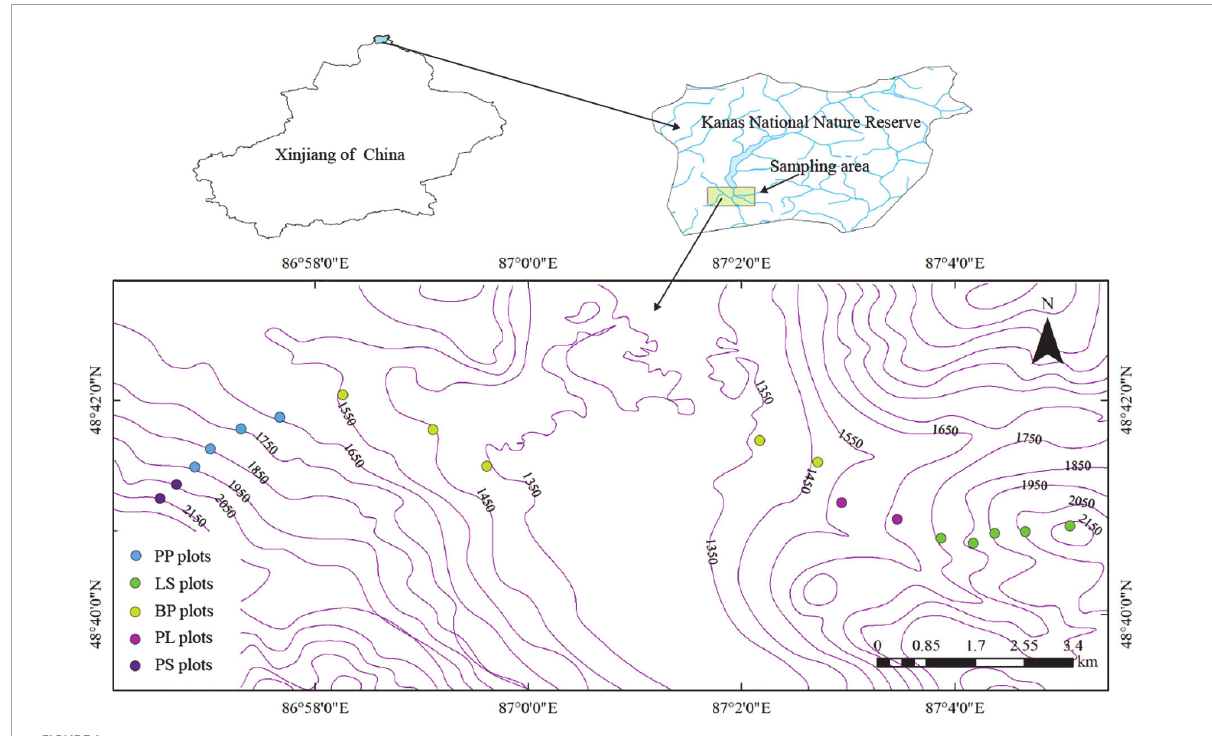
FIGURE1 Distribution of sampling site. Betula pendula forest (BP), Picea obovata + Larix sibirica mixed forest (PL), Larix sibirica forest (LS), Picea obovata + Pinus sibirica mixed forest (PP), and Pinus sibirica forest (PS).